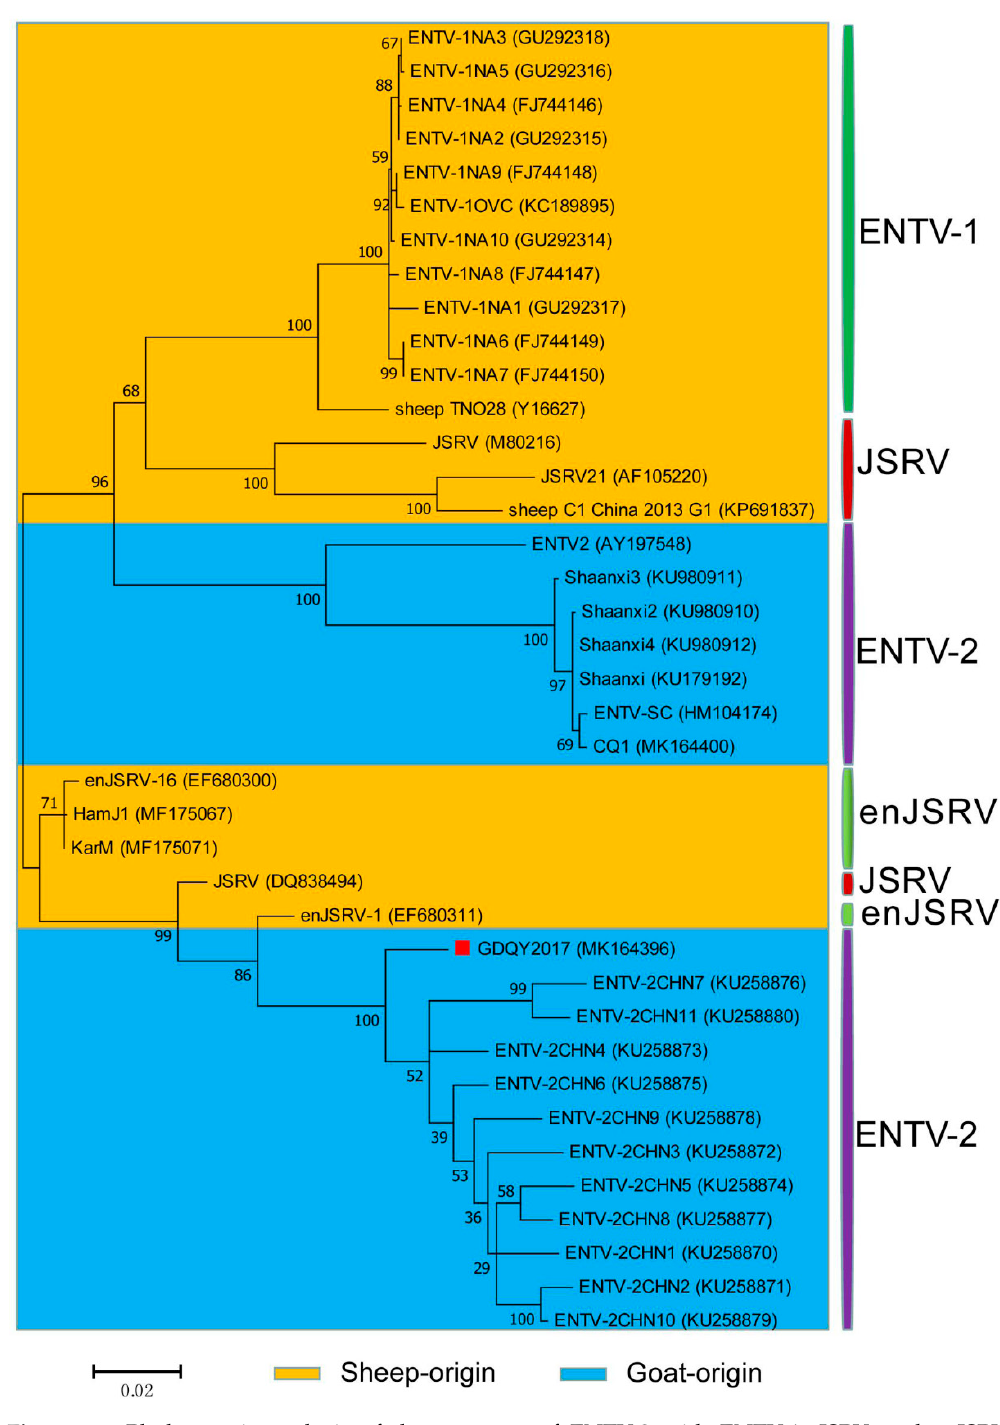
Figure 7. Phylogenetic analysis of the gag gene of ENTV-2 with ENTV-1, JSRV, and enJSRV. GDQY2017 described in this study was marked with the red square.